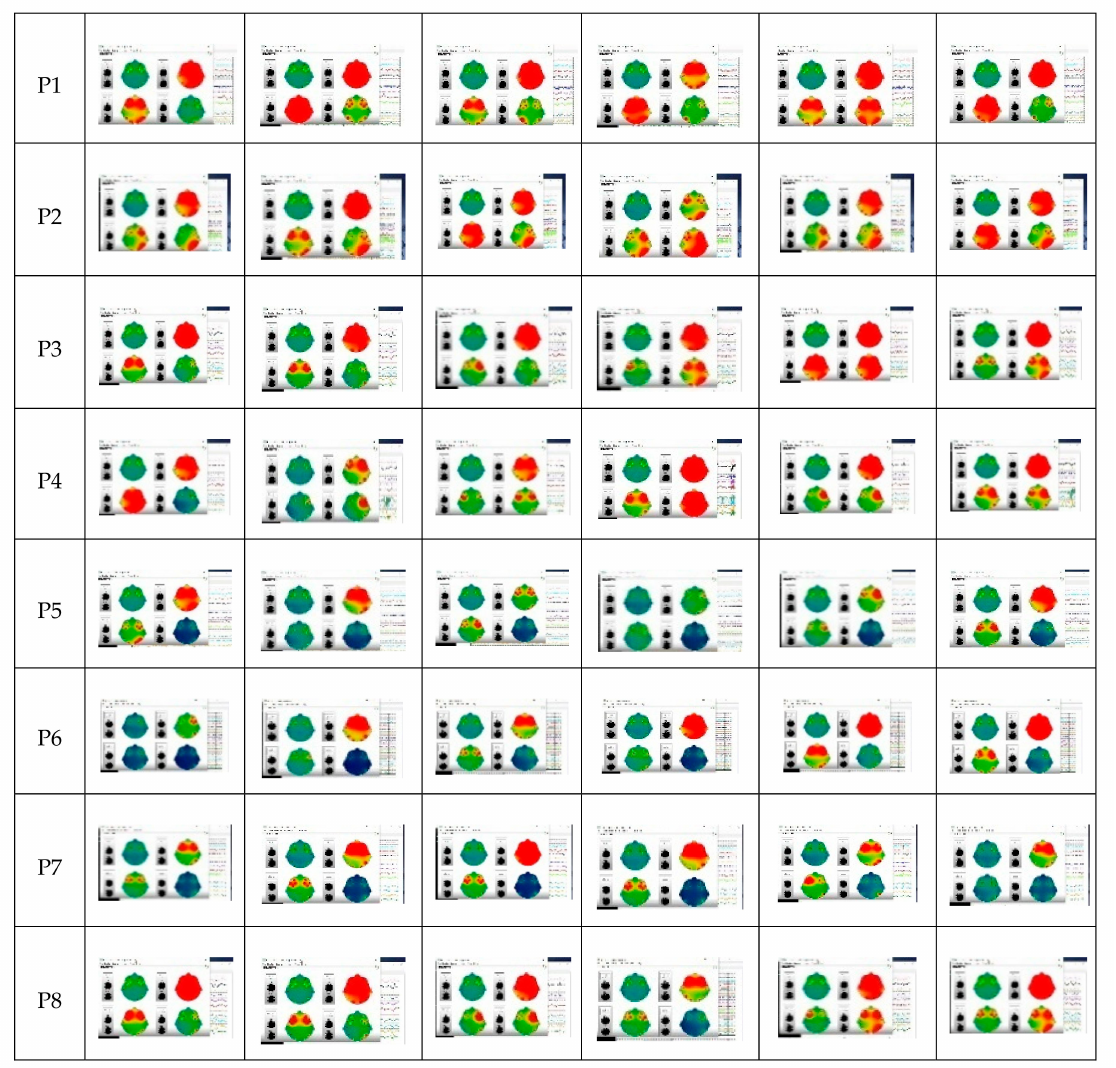
Figure 5. Brain activity sequences of eight participants (one line for each participant) in the “throwing” condition. Each frame shows the delta (upper-left), theta (upper-right), alpha (bottom-left), and beta (bottom-right) oscillations of each moment. These frames, taken every two seconds, correspond to the central 12” of the